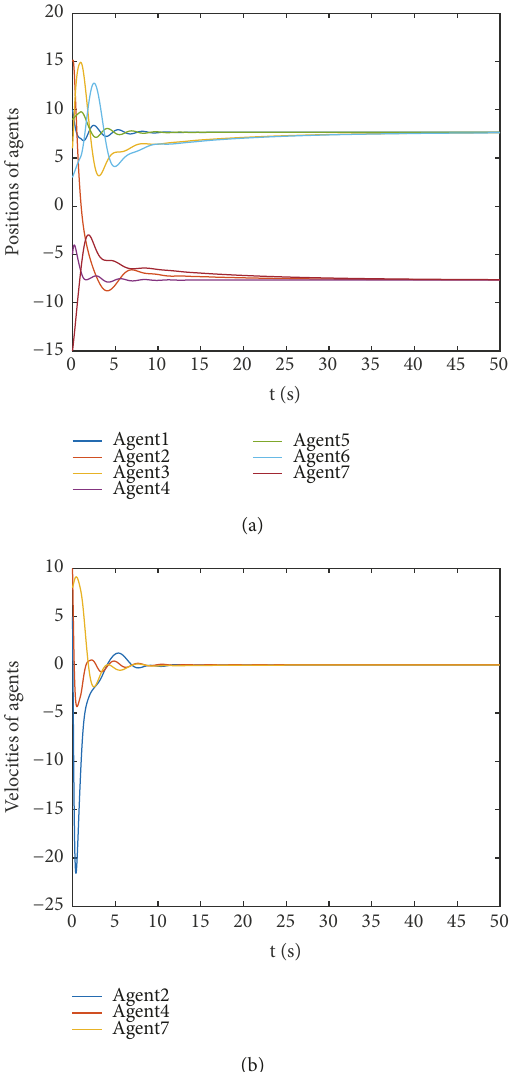
Figure8:Thestatetrajectoriesoftheagentsunderdirectedtopology in Figure 6 with different input time delays 𝜏 1 = 0.2 , 𝜏 2 = 0.1 , 𝜏 3 = 0.1 , 𝜏 = 0.1 , 𝜏 = 0.5 , 𝜏 = 0.5 , 𝜏 = 0.2 , communication delay 4 5 6 7 𝜏 = 0.9 . (a) Positions. (b) 𝑖𝑗